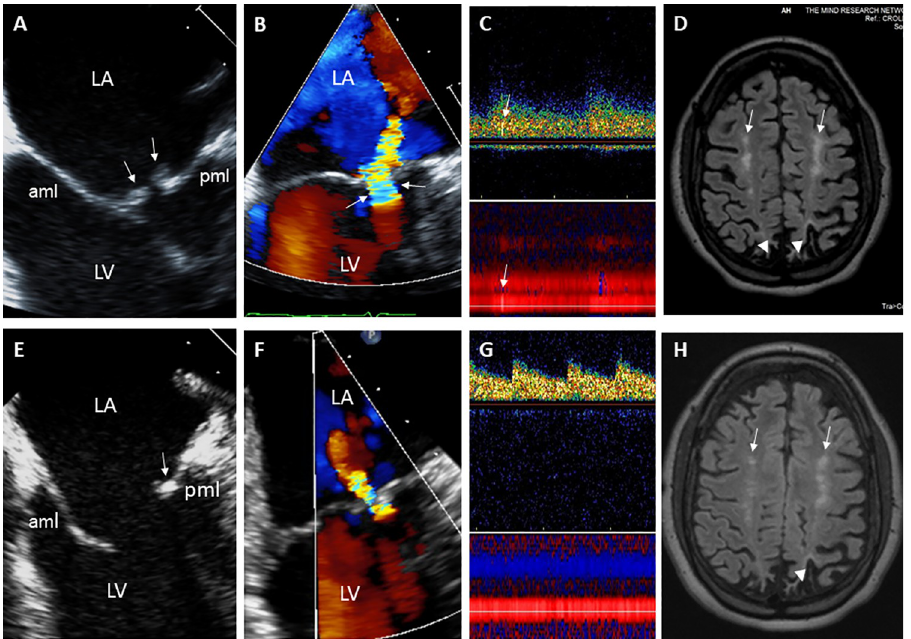
Fig 5. 21-year-old female with Libman-Sacks Endocarditis complicated with acute transient ischemic attack and previous stroke. A,B . These 2D and color-Doppler TEE views demonstrate a moderate size (area 0.85 cm 2 ), sessile, and oval shaped Libman-Sacks vegetations (arrows) on the distal portions and atrial side of the anterior (aml) and posterior (pml) mitral leaflets ( A ) and moderate to severe eccentric mitral regurgitation as demonstrated by a large flow convergence zone (arrows) ( B ). C . Transcranial Doppler of the left middle cerebral artery demonstrates 1 of 4 microemboli (arrows). D. On MRI, cerebral infarcts (arrowheads) and multiple white matter lesions (arrows) for a lesion load of 7.05 cm 3 were demonstrated. Her global neurocognitive dysfunction was graded as severe. E,F. After 3 months of warfarin, hydroxychloroquine, prednisone, and mycophenolate mofetil, repeat imaging demonstrated resolution of the anterior mitral valve vegetation and reduction in size (arrow) of the posterior mitral leaflet vegetation ( E ), reduction of mitral regurgitation to mild degree ( F ), resolution of cerebromicroembolism ( G ), and decrease in count and size of white matter lesions (arrows in H ) to a lesion load of 4.2 cm 3 , and improvement in her global neurocognitive dysfunction to mild